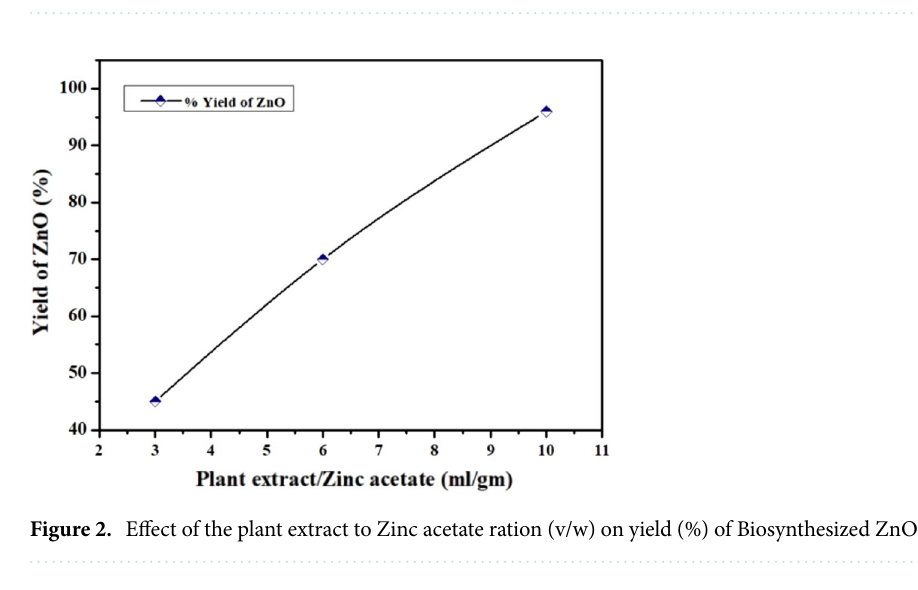
Figure 1. Green synthesis of zinc oxide nanoparticles by using Nigella sativa as a reducing agent.